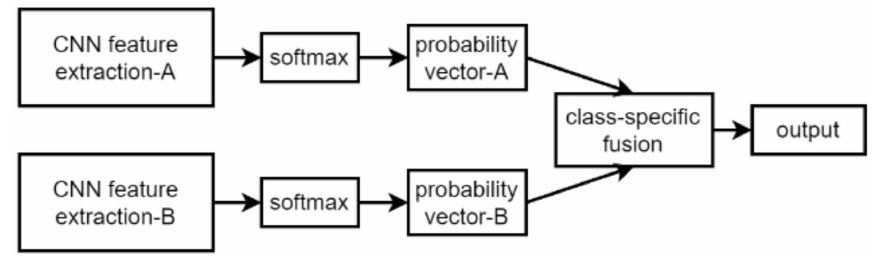
Figure 1. The 2S-CNN structure.